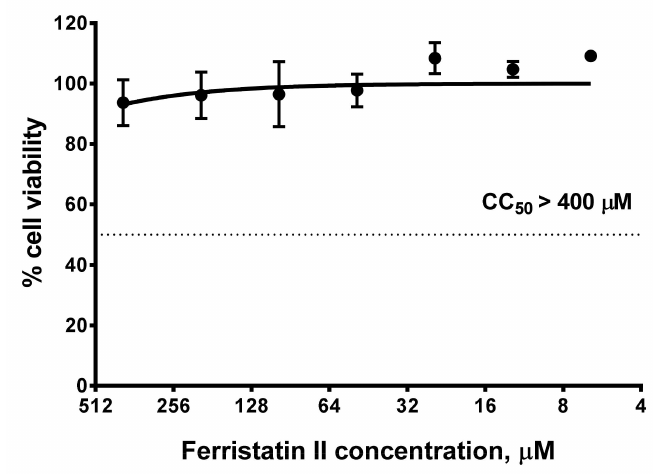
Figure 4. Cytotoxicity of ferristatin II for Vero cells. The cells were incubated for 2 days in the presence of indicated concentrations of ferristatin II, followed by the assessment of cell viability using MTT assay. Data are presented as the mean ± SD ( n =